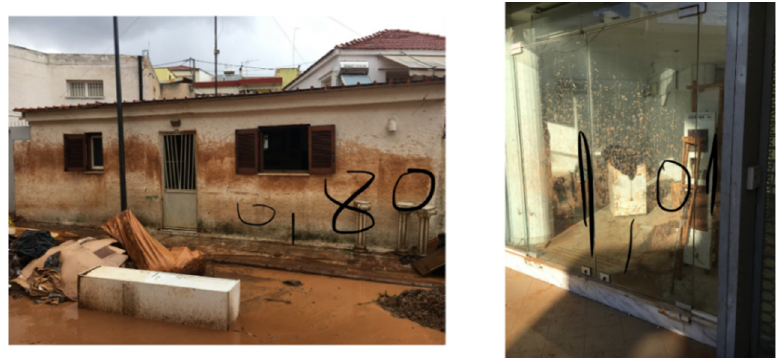
Figure 5. Indicative observation points in Mandra town (inside the buildings): the observed maxi- mum depths are 1.15 m (left), 1.90 m (middle), 1.06 m (right).